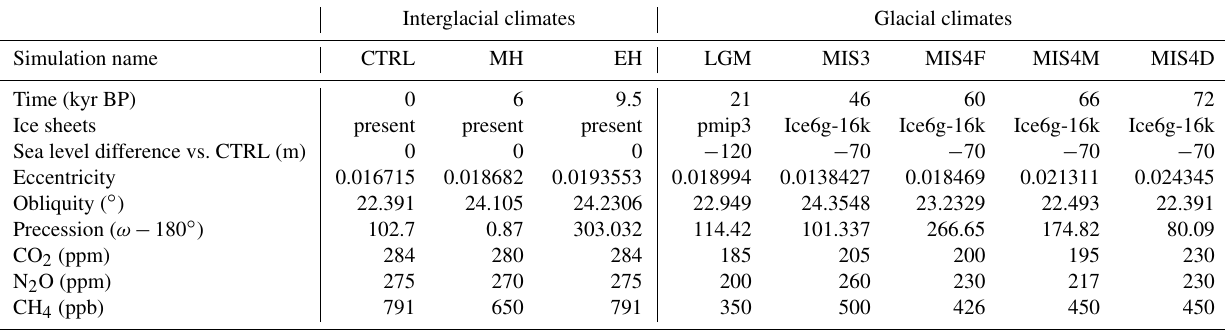
Table 1. Boundary conditions for the eight simulations studied in this work. Precession is defined as the longitude of the perihelion, relative to the moving vernal equinox, minus 180 ◦ . Ice sheets are represented in Fig. 1. Pmip3 ice sheet stands for the PMIP3 ice sheet reconstruction (Abe-Ouchi et al., 2015), ICE6g-16k stands for the ICE6G reconstruction at 16kyrBP (Peltier et al., 2015). Interglacial